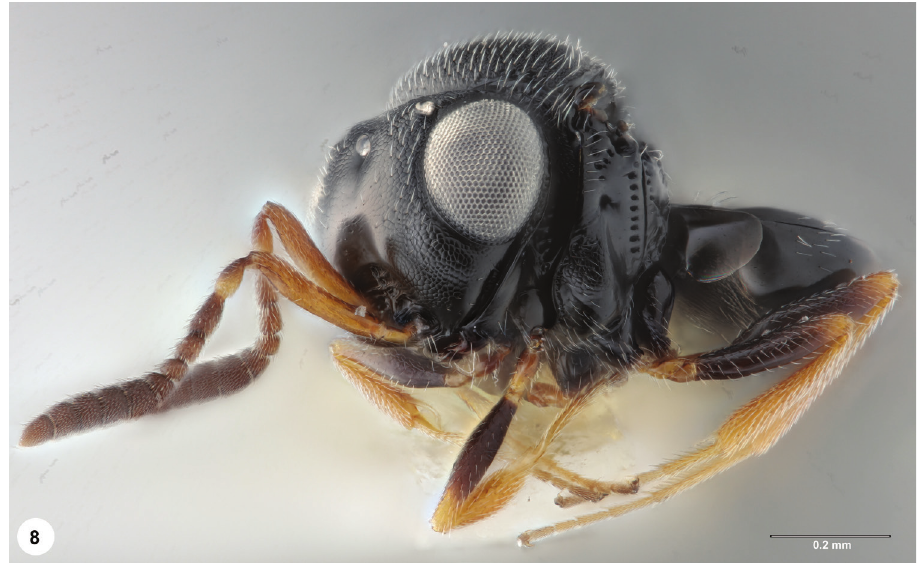
Figure 8. Trissolcus darreh , holotype female (FSCA 00095713), habitus, anterolatereal Head. Facial striae: absent. Number of clypeal setae: 2. Shape of gena in lateral view: narrow. Genal carina: absent. Malar striae: absent. Sculpture of malar sulcus: unknown. Orbital furrow: constricted or poorly defined ventrally. Macrosculpture directly dorsal to the antennal scrobe: absent. Preocellar pit: present. Setation of lateral frons: moderately dense. Punctation of lateral frons: absent. Sculpture directly ventral to preocellar pit: smooth. Rugae on lateral frons: absent. OOL: less than one ocellar diameter. Hyperoc- cipital carina: present, weakened medially. Macrosculpture of posterior vertex: absent. Microsculpture on posterior vertex along occipital carina: coriaceous. Anterior margin of occipital carina: crenulate. Medial part of occipital carina in dorsal view: rounded. Mesosoma. Epomial carina: present. Macrosculpture of lateral pronotum directly anterior to netrion: finely rugulose. Netrion sulcus: incomplete, not well-defined dor- sally. Pronotal suprahumeral sulcus in posterior half of pronotum: undifferentiated from sculpture of dorsal pronotum. Number of episternal foveae: 0; 1; 2. Course of episternal foveae ventrally: distinctly separate from postacetabular sulcus. Course of episternal foveae dorsally: distinctly separate from mesopleural pit. Subacropleural sulcus: present. Speculum: transversely strigose; smooth. Mesopleural pit: extending ventrally into slender, shallow furrow. Mesopleural carina: absent. Sculpture of femoral depression: smooth. Patch of striae at posteroventral end of femoral depression: ab- sent; indicated by lines of microsculpture. Setal patch at posteroventral end of femoral depression: present as a line of setae. Microsculpture of anteroventral mesopleuron: present only on anterior face of mesopleuron bulge. Macrosculpture of anteroventral mesopleuron: absent. Postacetabular sulcus: comprised of small crenulae. Mesopleural epicoxal sulcus: present as a smooth furrow. Setation of posteroventral metapleuron: